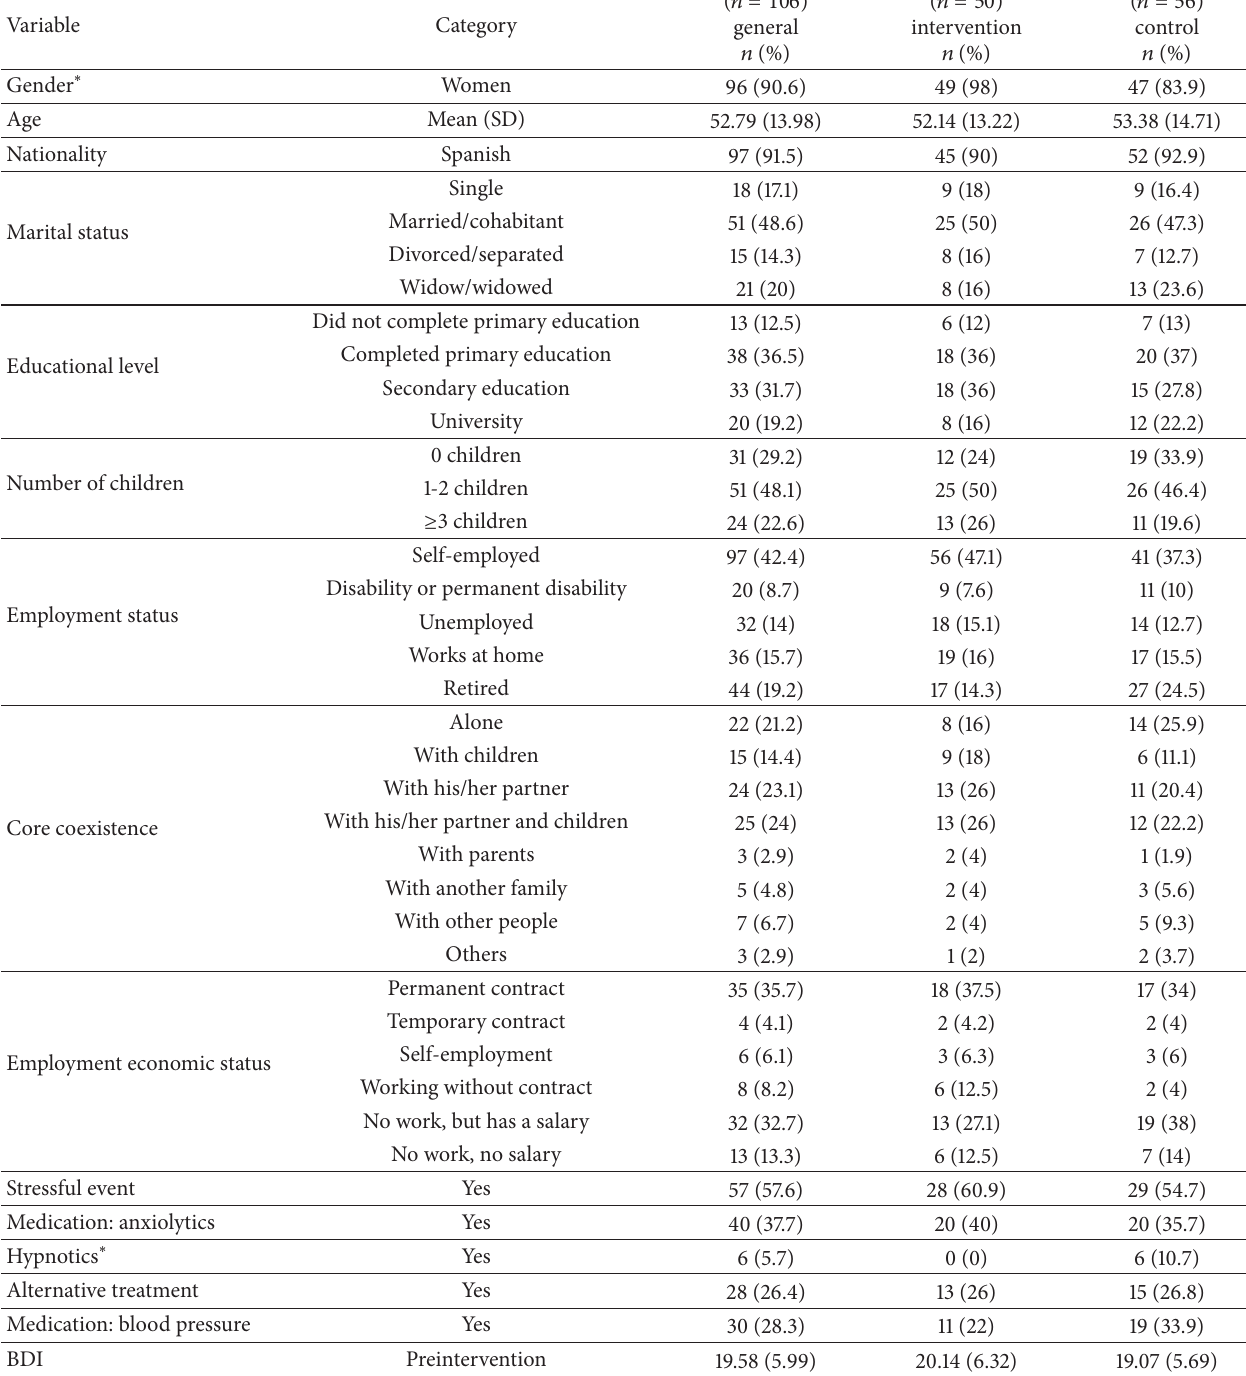
Table 1: Baseline characteristics of the total study population and the intervention group. Values are expressed as numbers